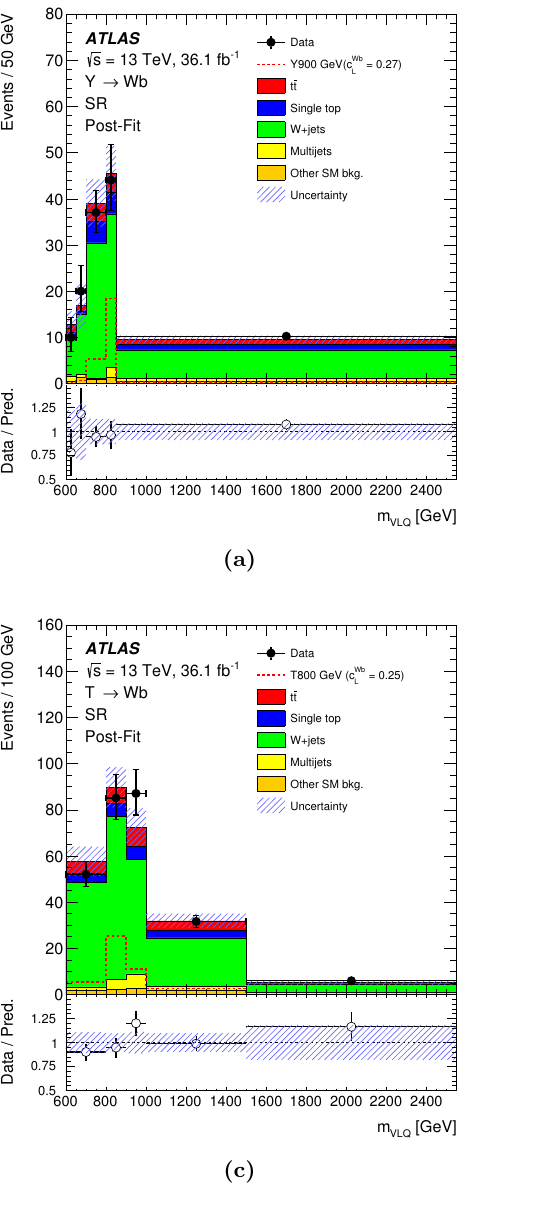
Figure 7. Distributions of the VLQ candidate mass, m VLQ , after the (cid:12)t to the background-only hypotheses for four di(cid:11)erent binnings chosen for four di(cid:11)erent signal masses. The (cid:12)rst and last bin include the under(cid:13)ow and over(cid:13)ow respectively. The VLQ candidate mass distributions for (a) a left-handed Y signal with mass 900 GeV and coupling c Wb = 0.27, (b) a left-handed Y signal with L mass 1500 GeV and coupling c Wb = 0.64, (c) a left-handed T signal with mass of 800 GeV and L coupling c Wb = 0.25 and (d) a left-handed T signal with mass 1200 GeV and coupling c Wb = 0.49 L L are also shown; all signal distributions include interference. The lower panels show the ratio of data to the (cid:12)tted background yields. The error bars represent the statistical uncertainty in the data. The band represents the total systematic uncertainty after the maximum-likelihood (cid:12)t.